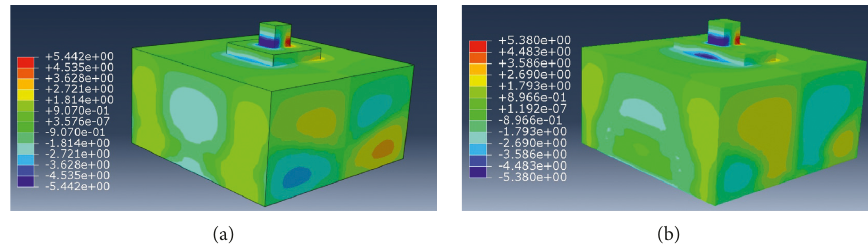
Figure 11: Cyclic stress invariant for configurations 1 and 2. (a) Configuration-1. (b)